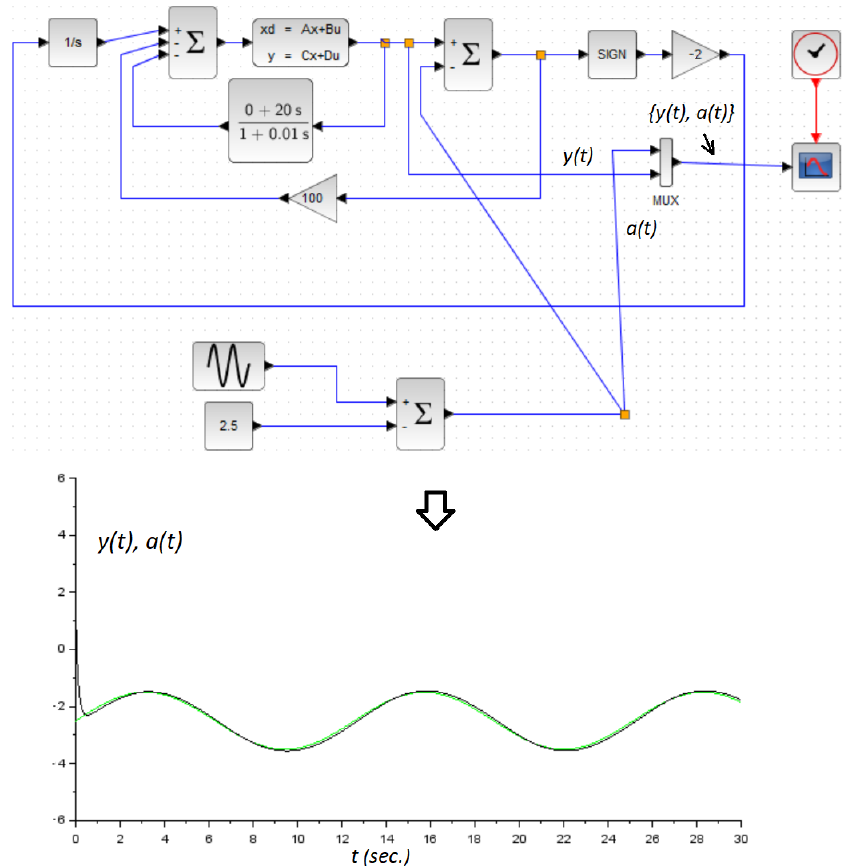
Figure 6. Numerical example: A sinusoidal reference signal case. The green line is the reference signal a ( t ) , and the black line is the system response y ( t ) .